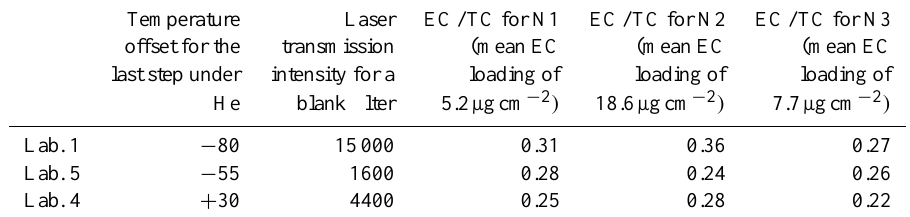
Table 5. Dependence of EC/TC on the temperature offset of the front oven and/or on the laser intensity for laboratories using the same thermal protocol (EUSAAR 2). Temperature Laser EC/TC for N1 EC/TC for N2 EC/TC for N3 offset for the transmission (mean EC (mean EC (mean EC last step under intensity for a loading of loading of loading of He blank filter 5.2µgcm − 2 ) 18.6µgcm − 2 ) Lab. 1 − 80 15000 Lab.